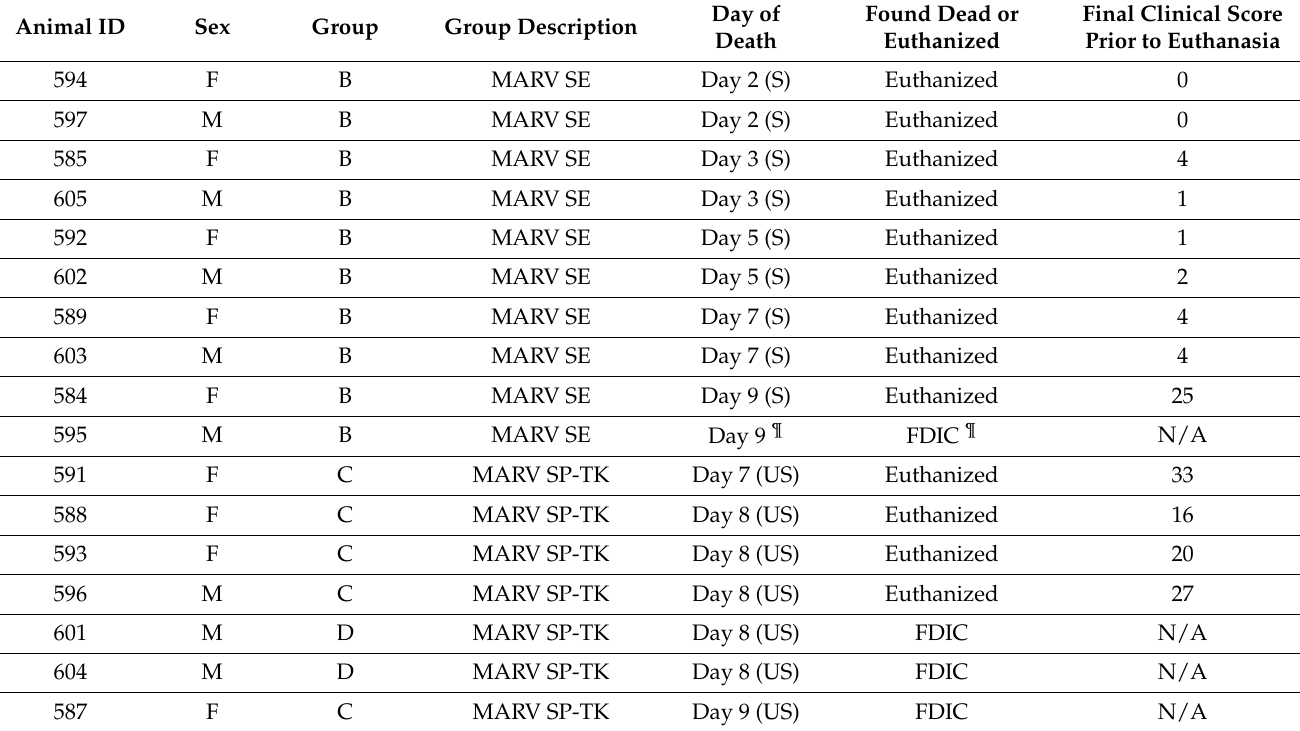
Table 1. Animal group description, day of death, and final clinical score